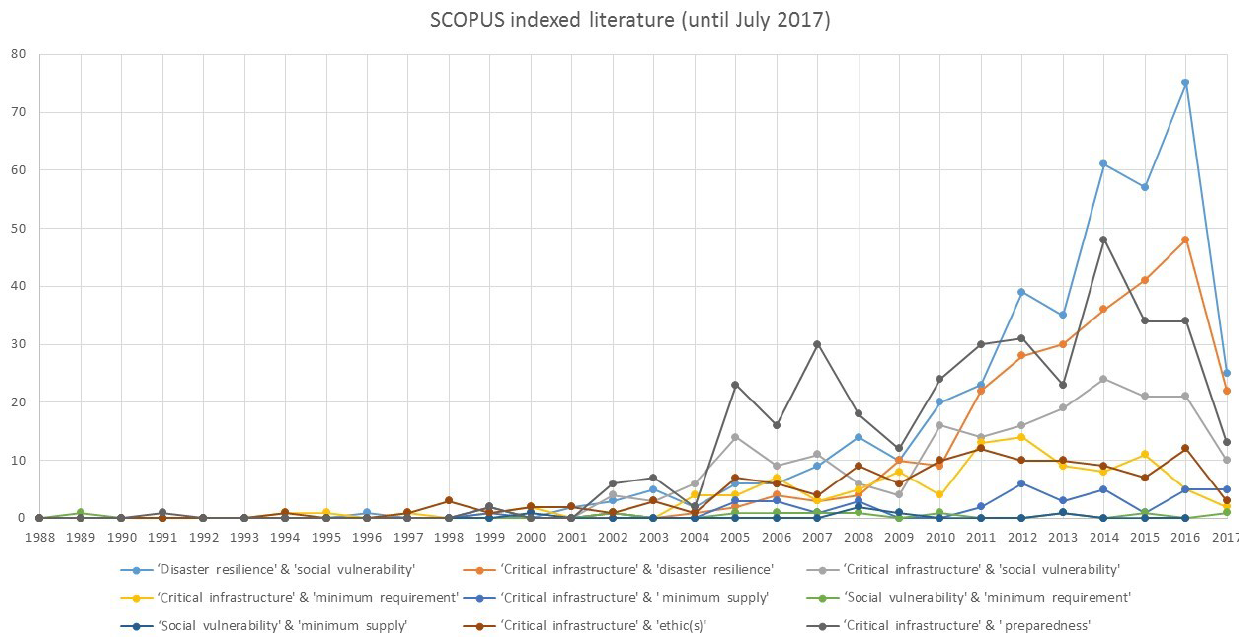
Figure 1. Scientific publications related to critical